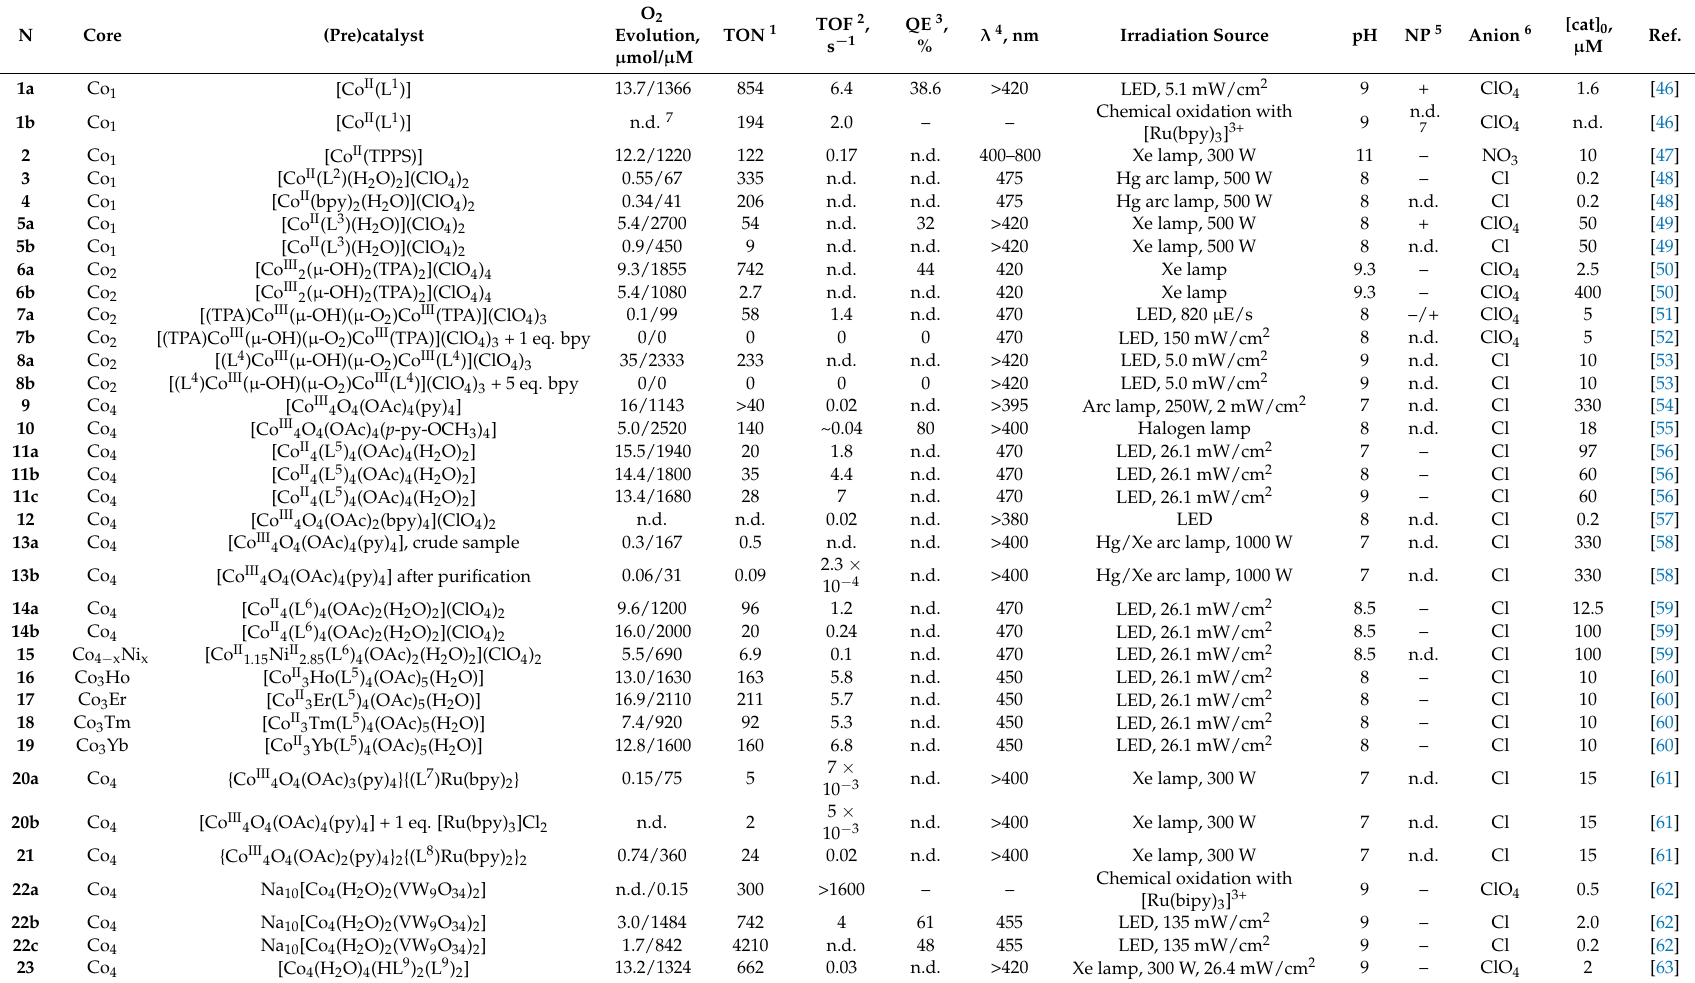
Table 1. Selected catalytic parameters for the catalysts 1 – 33 in oxidation of water using [Ru(bpy) 3 ] 2+ as a photosensitizer and S 2 O 82 − as a sacrificial electron